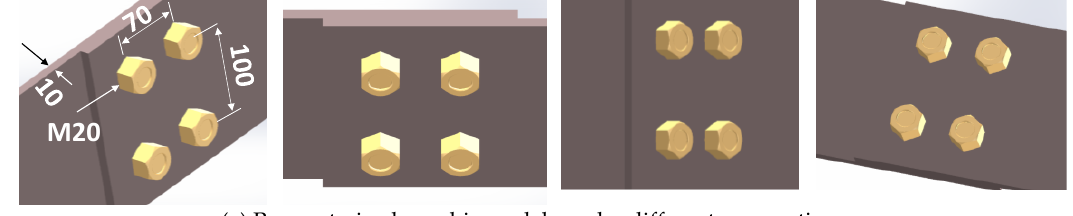
Figure 6. Accuracy and cross-entropy loss of the bolt detector during the training process.